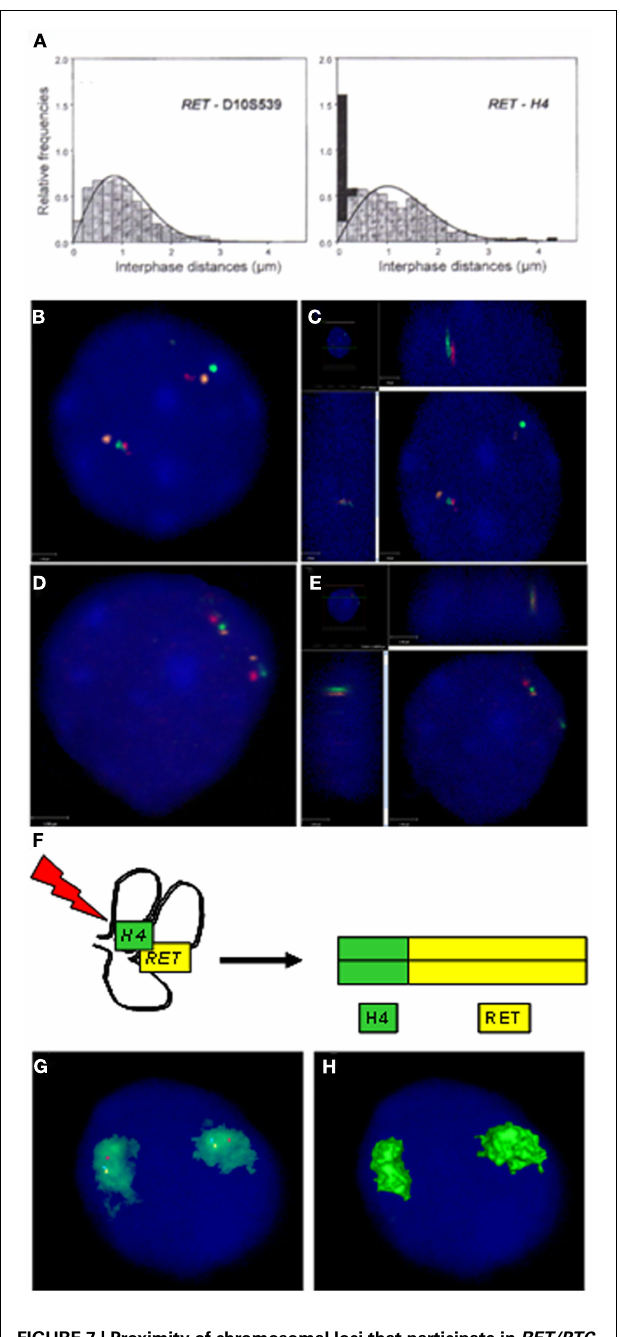
FIGURE 7 | Proximity of chromosomal loci that participate in RET/PTC rearrangements. (A) Fluorescence in situ hybridization (FISH) analysis of the distance between RET and H4/CCDC6 loci within interphase nuclei showed that, despite a linear distance of 18Mb, at least one pair of RET and H4/CCDC6 was juxtaposed in 35% of normal human thyroid cells (right panel). Conversely, the set of numbers obtained measuring the distance between RET and the control locus D10S539 fitted with the expected Rayleigh distribution (left panel; from Nikiforova et al. (2000) with permission of the American Association for the Advancement of Science). (B) 2D image of three-color FISH showing positioning of RET